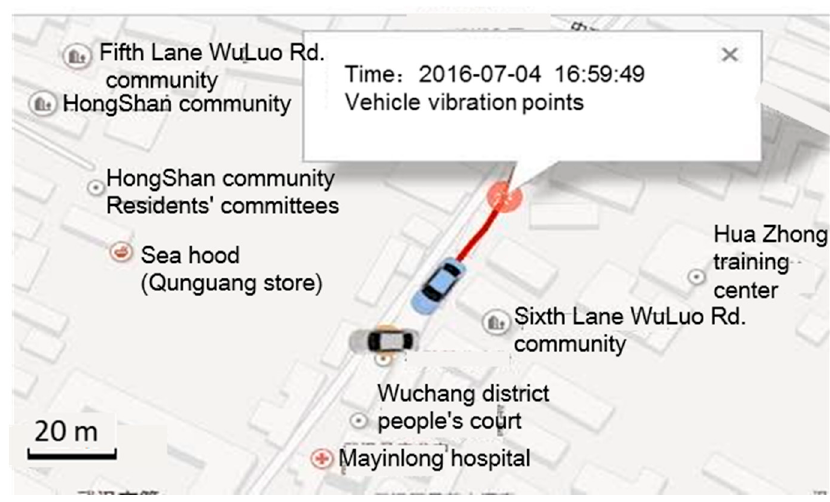
Figure 11. The situation of two ordinary GPS-based cars after an accident.